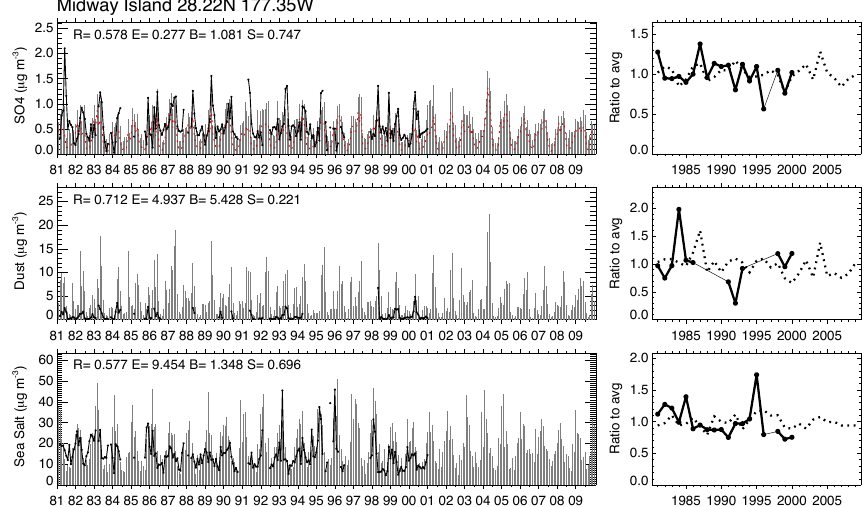
Fig. 10b. Same as Fig. 10a but for Midway Island in the North Pacific. Right column shows the ratio of annual mean concentrations to the average value over the available measurement years.